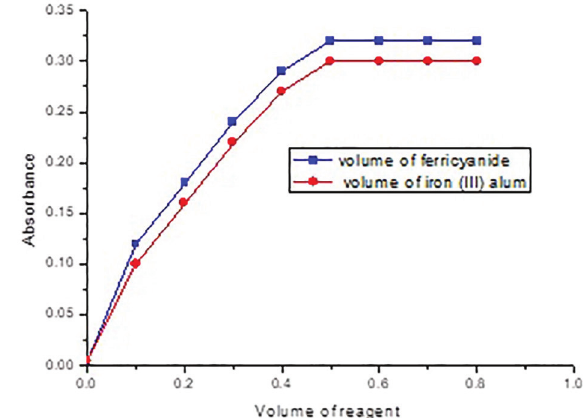
FIGURE 4 - Effect of iron(III) and ferricyanide (method A) (VLGH: 10 µg mL -1